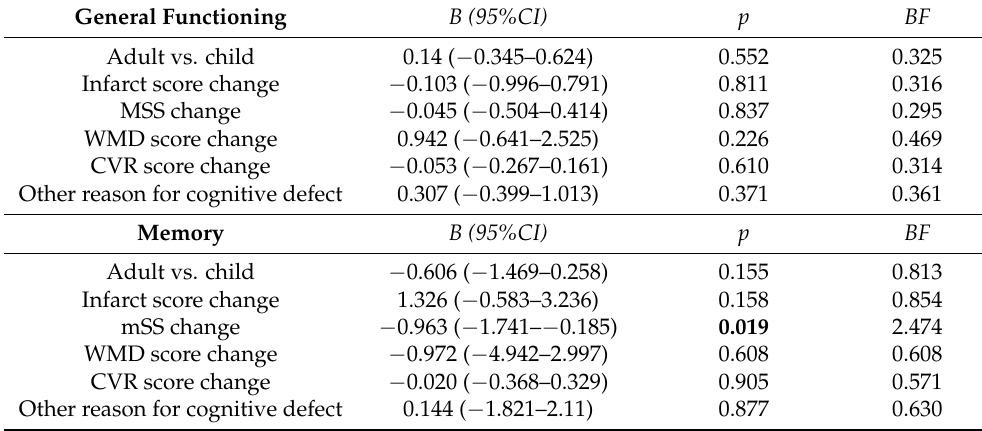
Table 2. Multivariable regression analysis of possible determinants of change in cognitive do- main